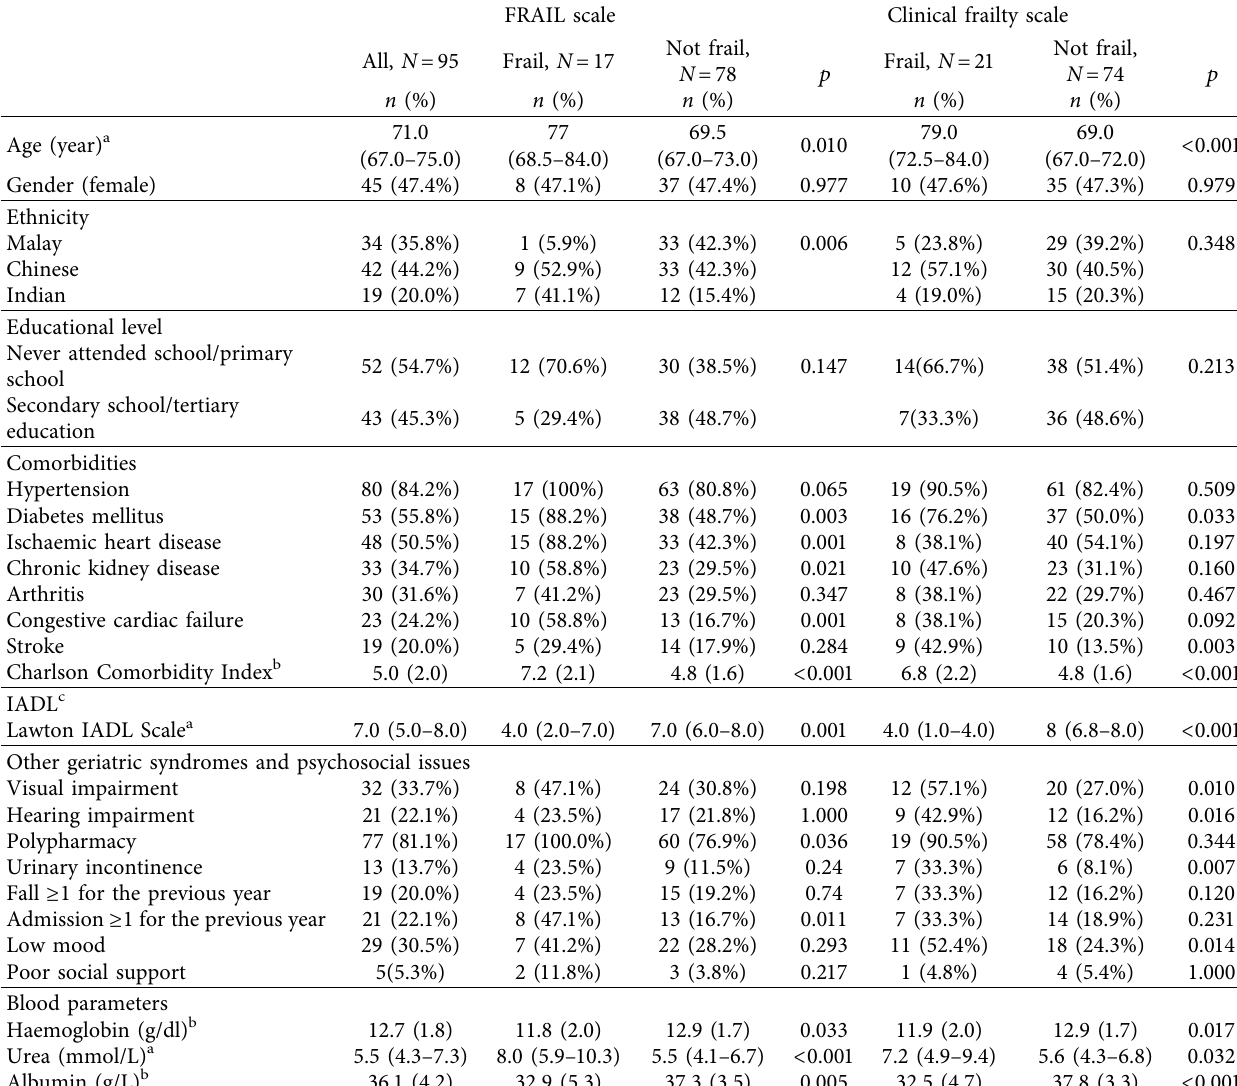
Table 1: Characteristics of community-dwelling older adults who attended general medical